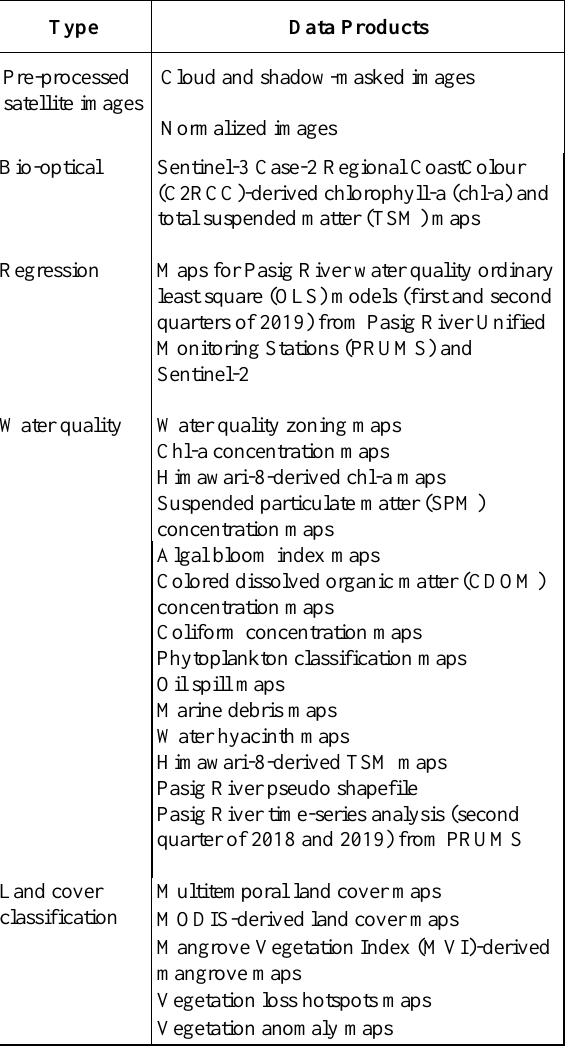
Table 4 . Data products available in MapABLE Web Portal.